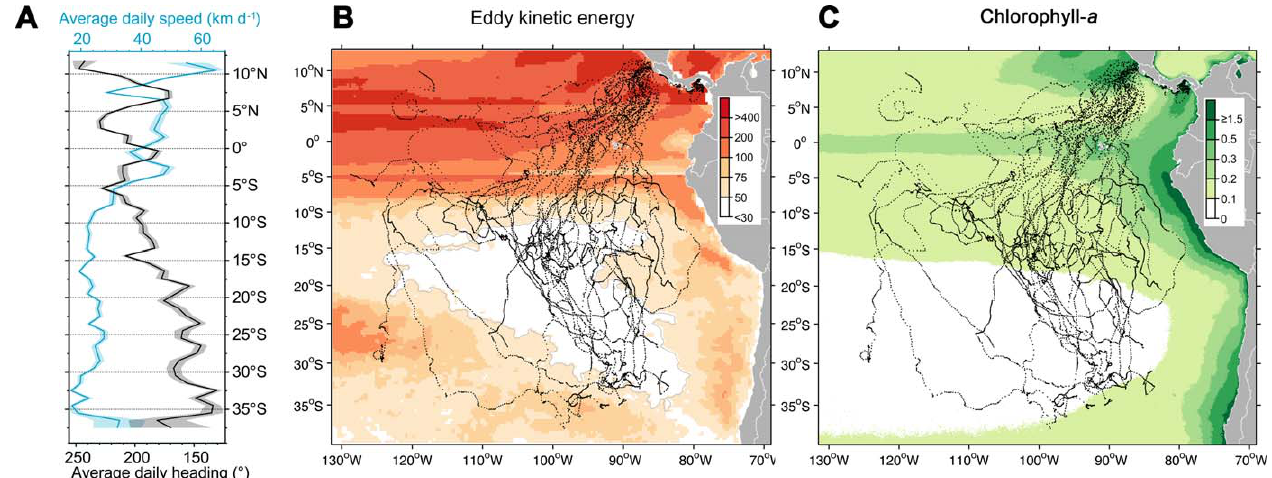
Figure 2. Large-Scale Oceanographic Characteristics and Leatherback Movements in the EP Turtle median daily positions (black dots) generated with state-space model interpolation [21], overlaid on long-term mean. (A) Turtle median daily speed (blue line) and heading (black line), with corresponding standard-error envelopes, averaged in one-degree latitudinal bins. (B) EKE (in cm 2 s (cid:2) 2 ). (C) Near-surface CHL concentration (in mg m (cid:2) 3